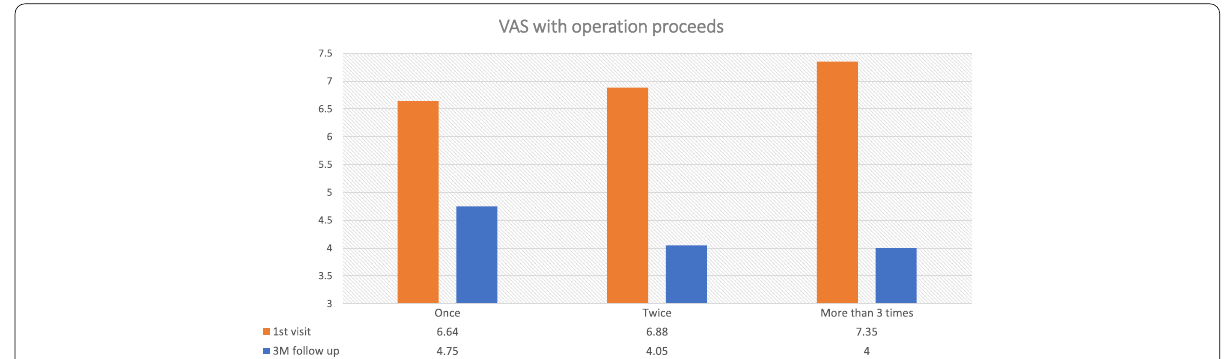
Fig. 6 The VAS at the 1st visit and the VAS after the treatment were compared according to the number of sialendoscopy